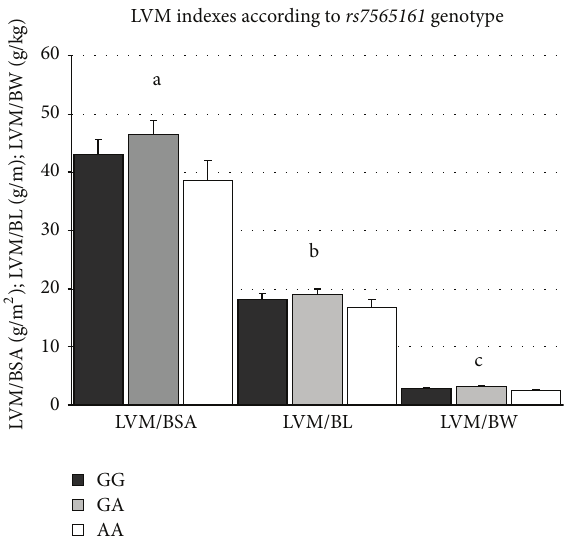
Figure 3: LVM indexes according to rs7565161 genotype. Mean and SEM are shown. a 𝑃 = 0.109 ; b 𝑃 = 0.306 ; c 𝑃 = 0.037 ; a , b , c GG versus GA versus